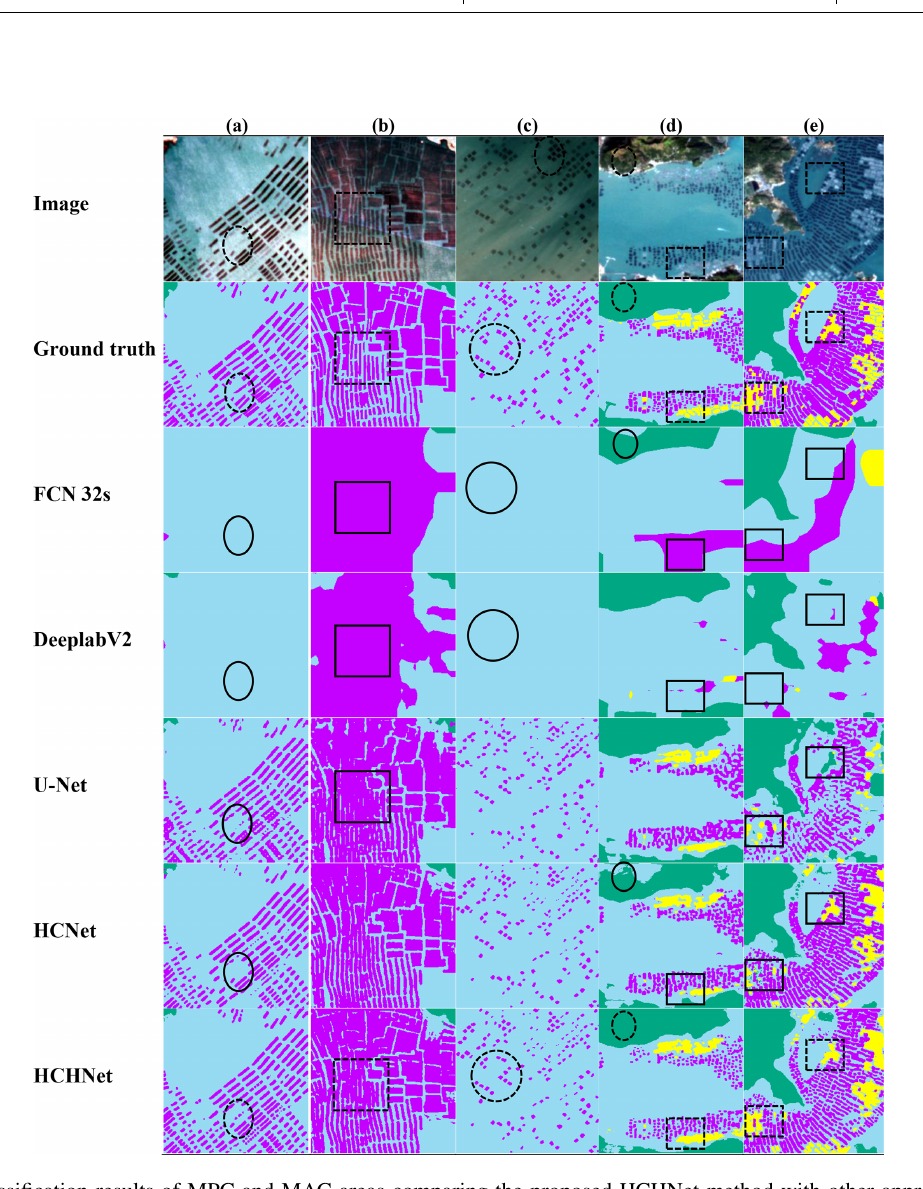
Earth Syst. Sci. Data, 13, 1829–1842,